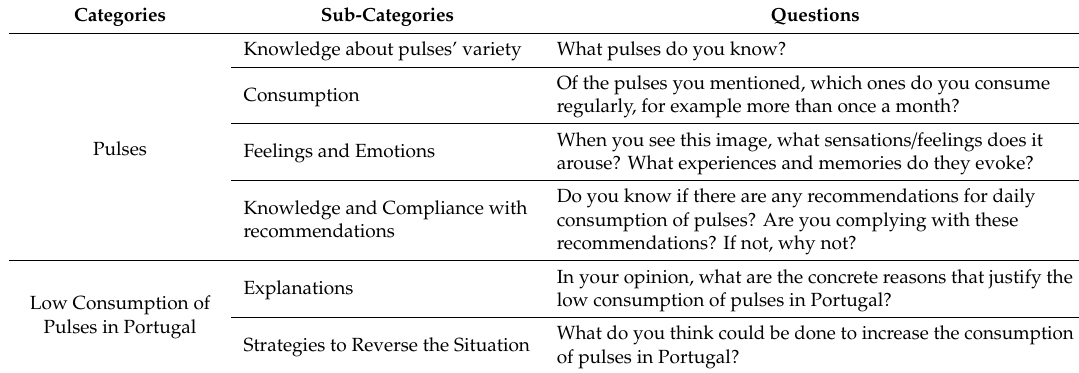
Table 1. Questions used in the personal